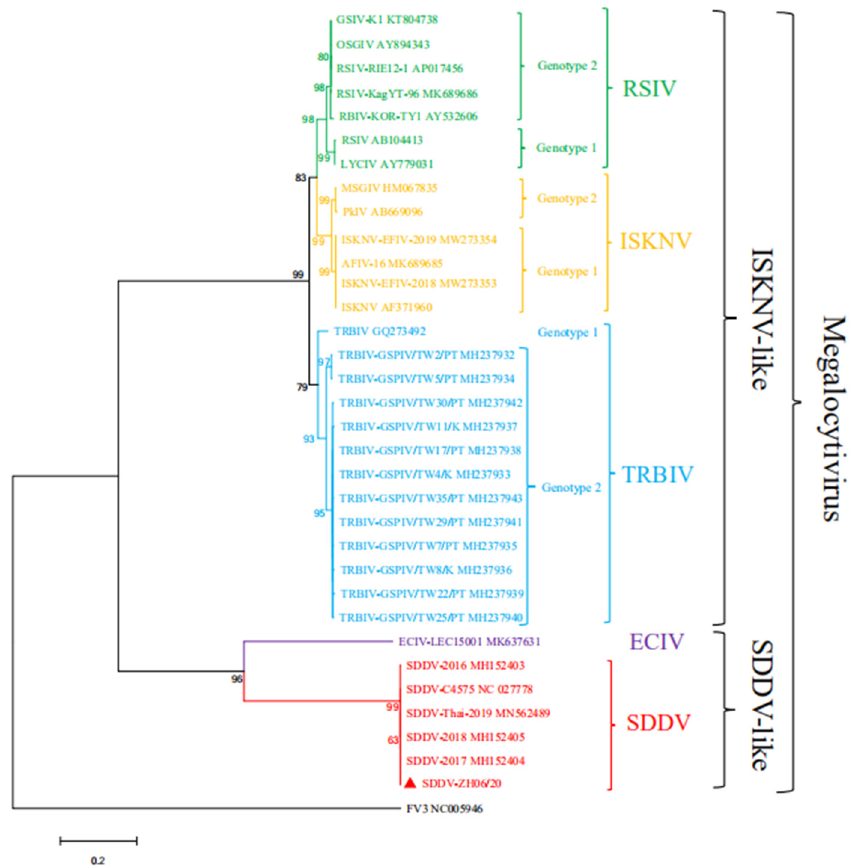
Figure 5. Phylogenetic relationship of ZH ‐ 06/20 and 32 other members in the genus Megalocytivirus based on the mcp gene. A red solid triangle indicated the ZH ‐ 06/20. The FV3 in genus Ranavirus was used as an outgroup. Generally, megalocyti ‐ virus could be divided into two subgroups. The ISKNV ‐ like subgroup includes RSIV, ISKNV, and TRBIV and the SDDV ‐ like subgroup includes SDDV and ECIV. Genomic sizes of viral members in ISKNV group are about 111,000 bp. By con ‐ trast, genomic sizes of members in the SDDV ‐ like group are 128,000~132,000 bp. FV3 in genus Ranavirus was used as an outgroup.